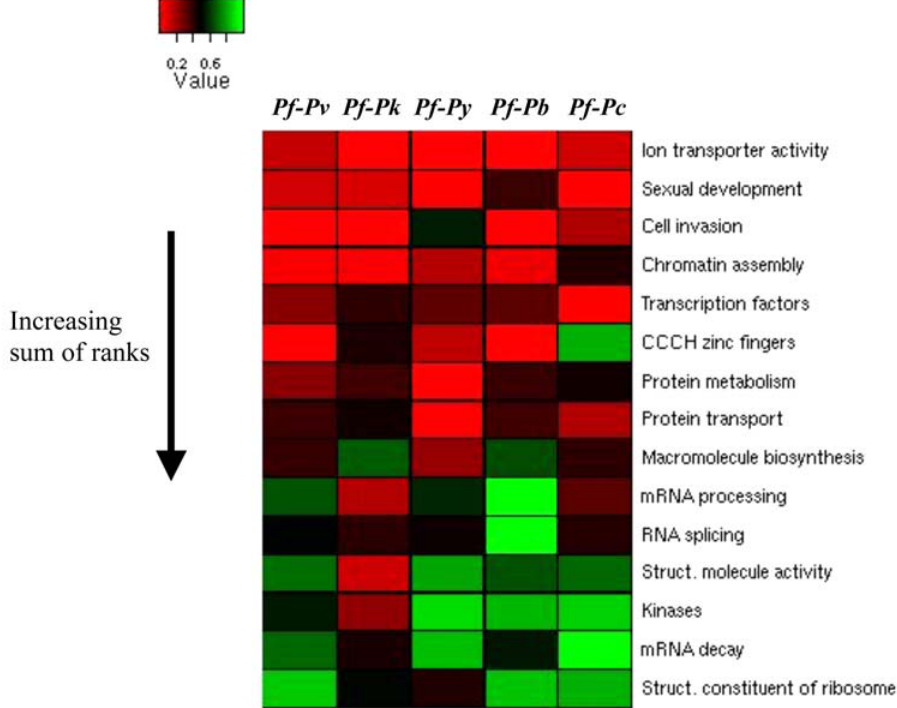
Figure 3. Gene groups arranged by level of constraint on upstream noncoding regions. Ion transport, sexual development, cell invasion, chromatin assembly, transcription factor and CCCH zinc finger genes have more constrained upstream regions than the other groups considered. Elements of the heatmap represent the p-values resulting from testing the alternative hypothesis that genes in a particular group rank among genes with the most constrained upstream regions (higher overlap scores) among all genes with orthologs in 2 particular species. The 15 groups were ranked from the most constrained to the least constrained in each of the 5 cross-species comparisons and the sum of the ranks (Table S6) was determined and used to order the gene groups in the heatmap. Pf-Pv, Pf-Pk, Pf-Py, Pf-Pb and Pf-Pc represent results from comparisons between P. falciparum and P. vivax, P. knowlesi, P. yoelii, P. berghei and P. chabaudii respectively.